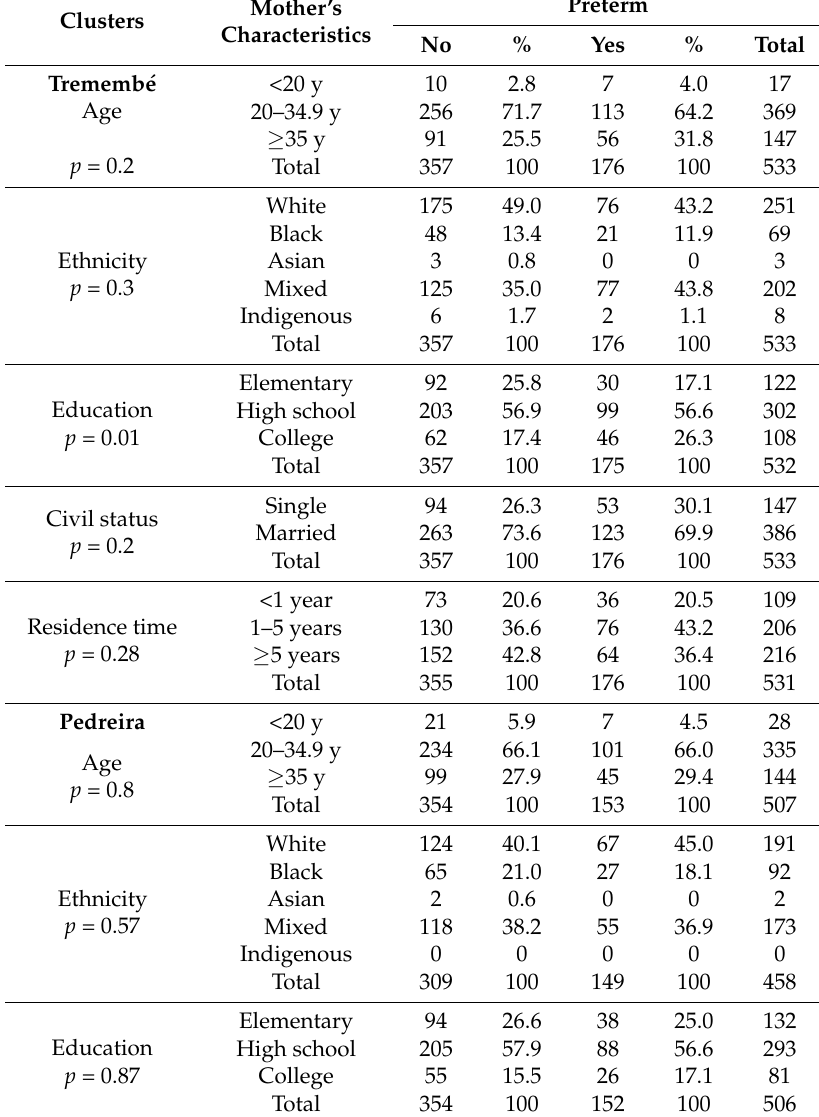
Table 1. Distribution of the characteristics of the mothers in each cluster. The p values depicted in the first column represent the level of significance of the differences between preterm and term